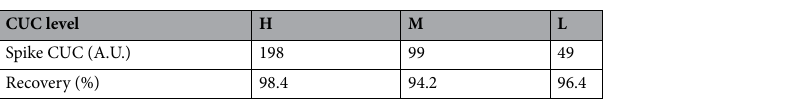
Table 3. Spike recovery testing. HDL concentrates with high, middle, and low CUC were added to blank serum samples and the recovery rate was calculated. A.U. arbitrary units.